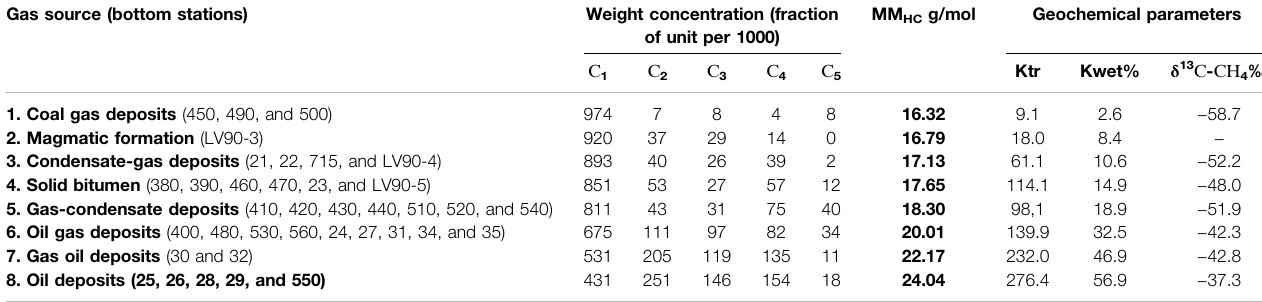
TABLE 4 | Average values of geochemical indicators of bottom sediment HCGs of the edge shelf zone of the East Siberian Sea and adjacent part of the Arctic Ocean. Gas source (bottom stations)